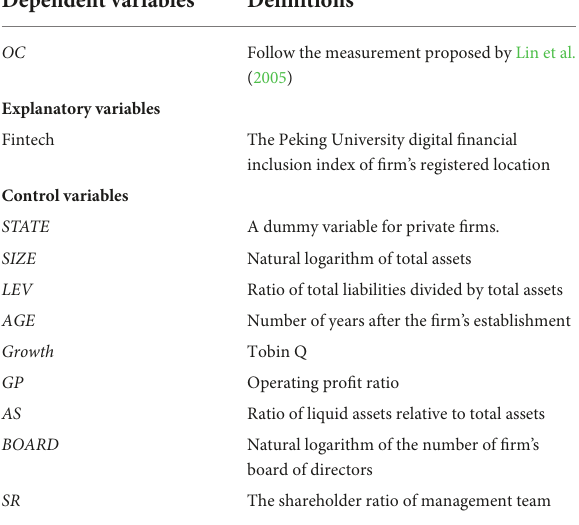
TABLE 1 Variable definitions.